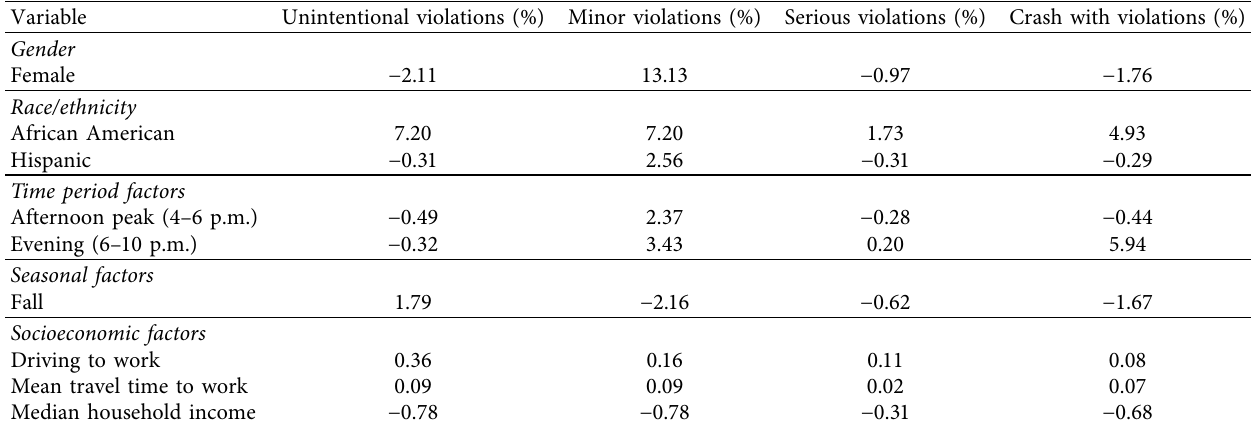
Table 5: Estimated elasticity values of the random parameter multinomial logit model for traffic violations by seriousness outcomes, in